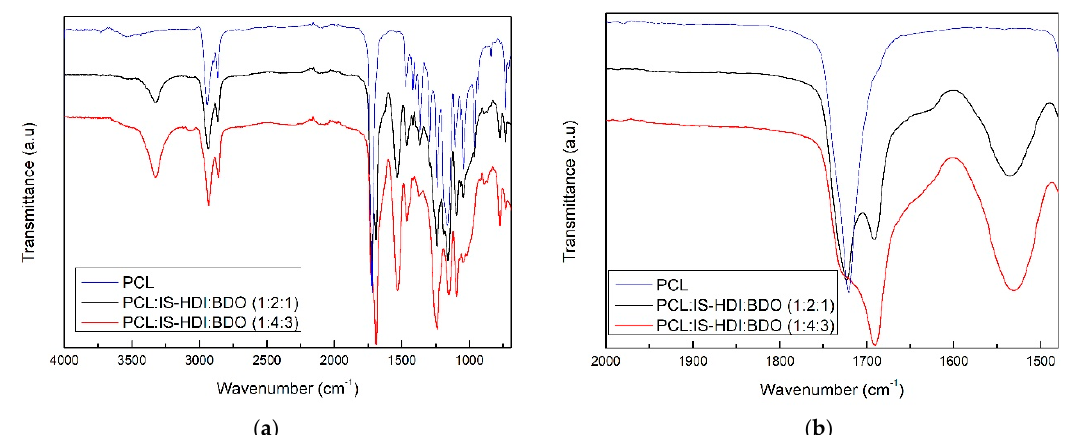
Figure 1. ( a ) FTIR spectra of PCL:IS-HDI:2,3-BDO and pure polyol ( b ) Amplification of carbonyl stretching region.